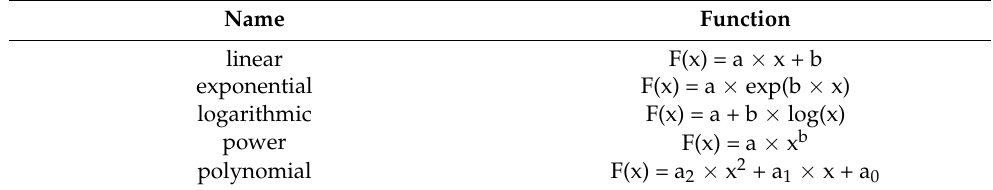
Table 7. List of tested parametric